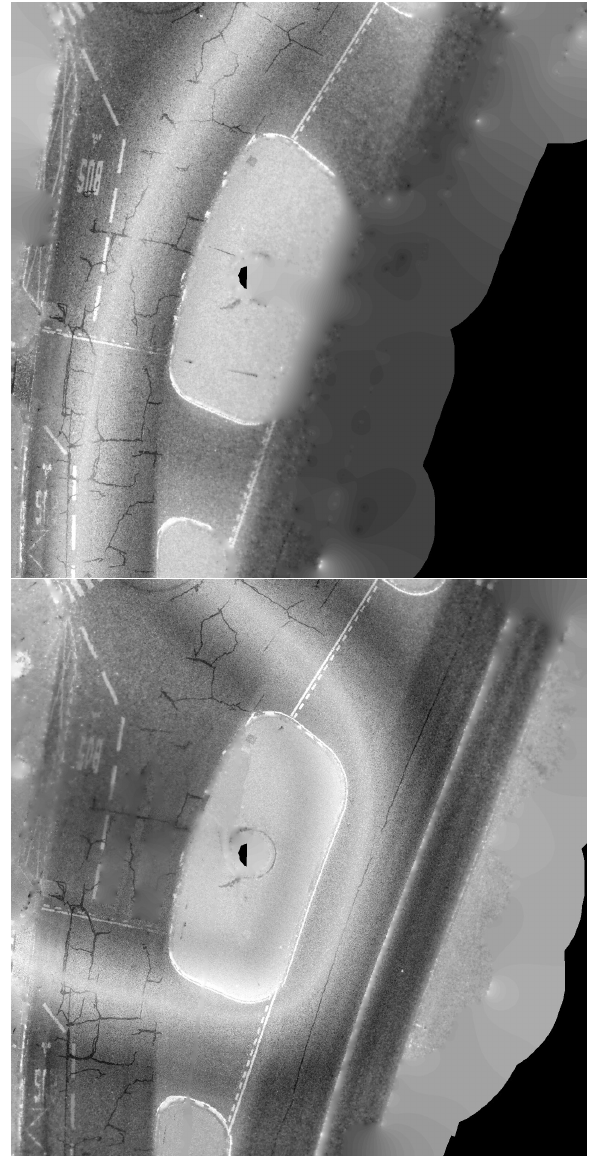
Figure 5: Illustration of Poisson interpolation on the other two layers of the tile of Figure